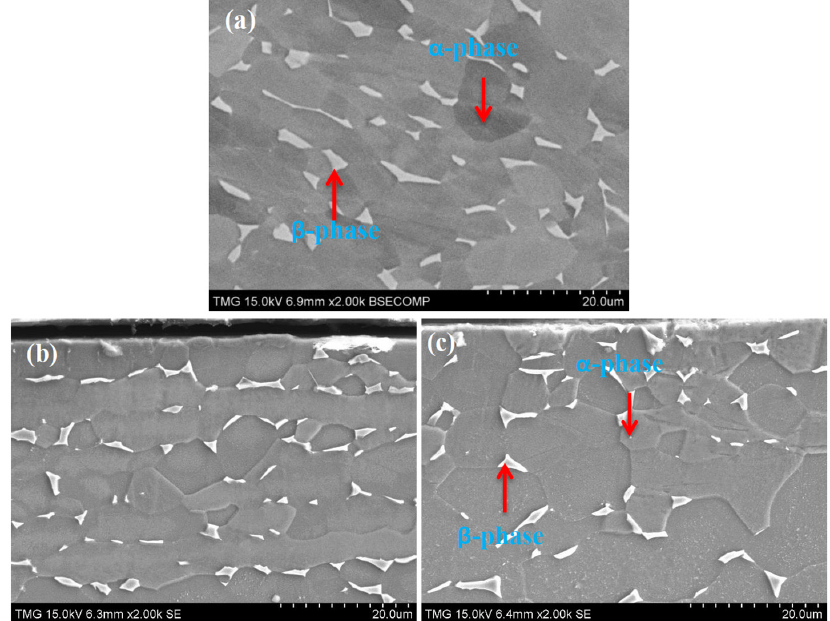
Figure 8. SEM micrographs showing ( a ) treated top surface ( b ) untreated cross ‐ section and ( c ) LSP treated cross ‐